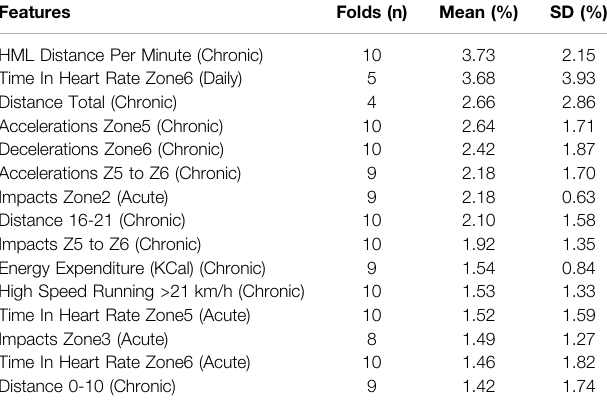
TABLE 5 | Feature importance of cross-validation. Features